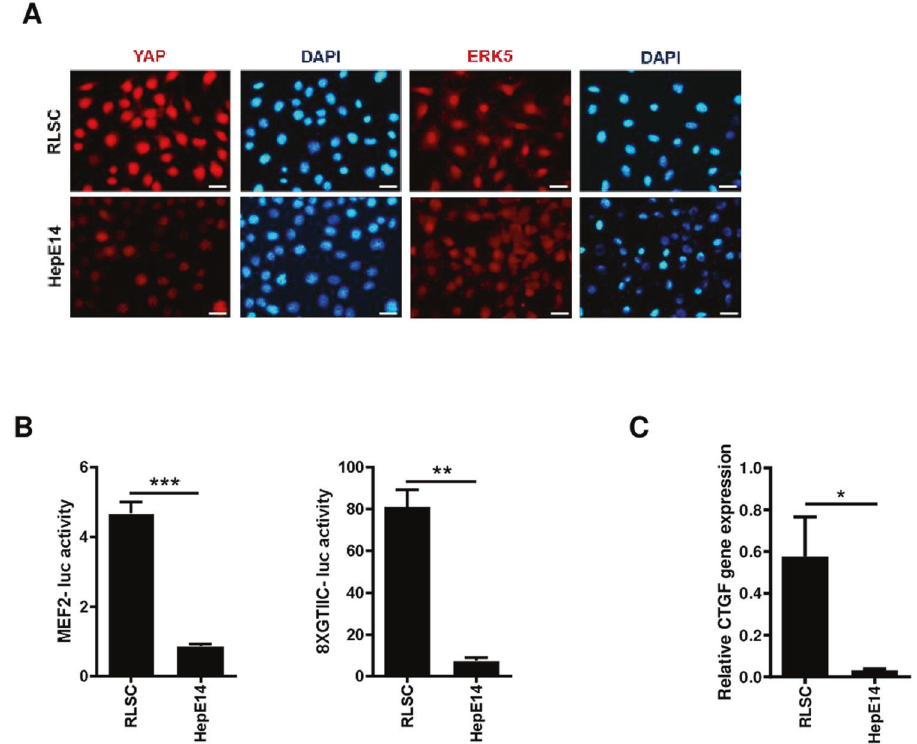
Fig. 1 ERK5 and YAP activity are directly correlated in liver cell differentiation. A Immuno fl uorescence analysis of RLSC and HepE14 cell lines. Cells were stained with anti-YAP or anti-ERK5 antibodies (red) and DAPI (nuclei, blue). Scale bar: 50 µm. B Luciferase assay. MEF2-luc